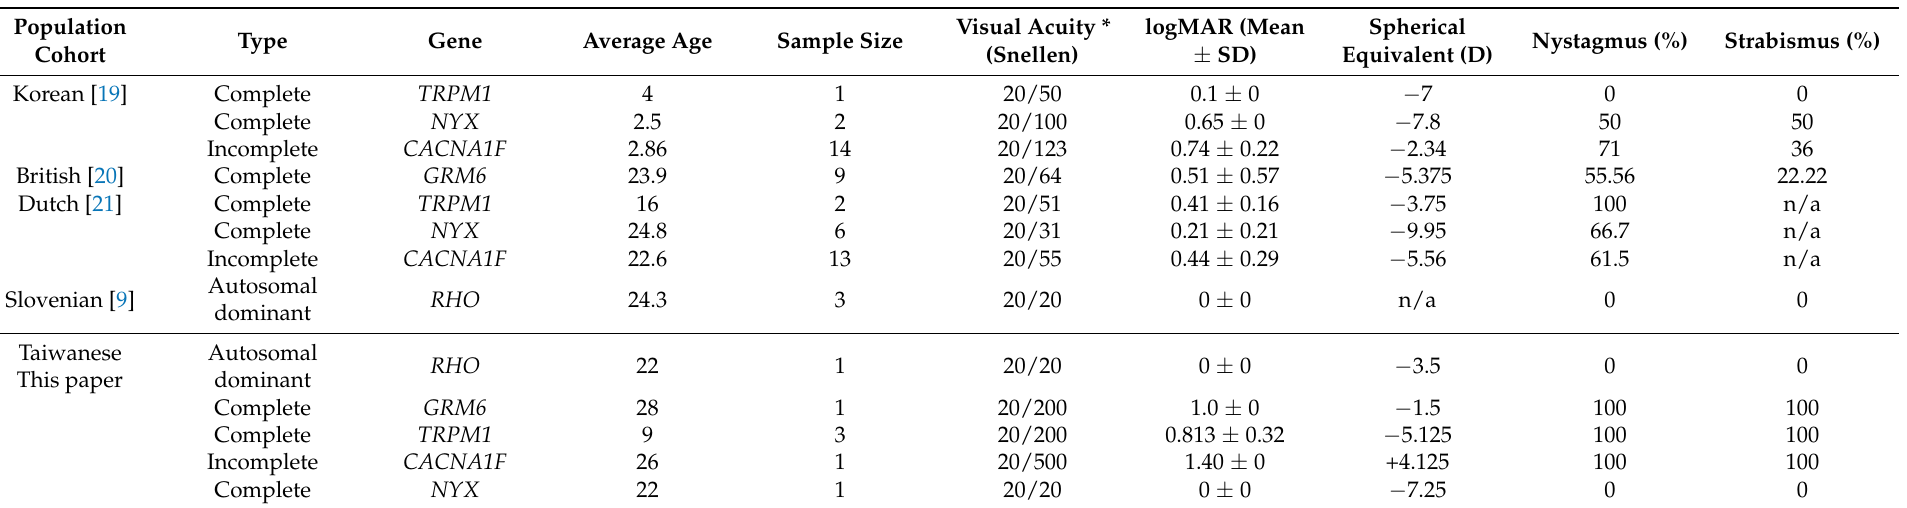
Table 5. Summary of clinical features compared to other